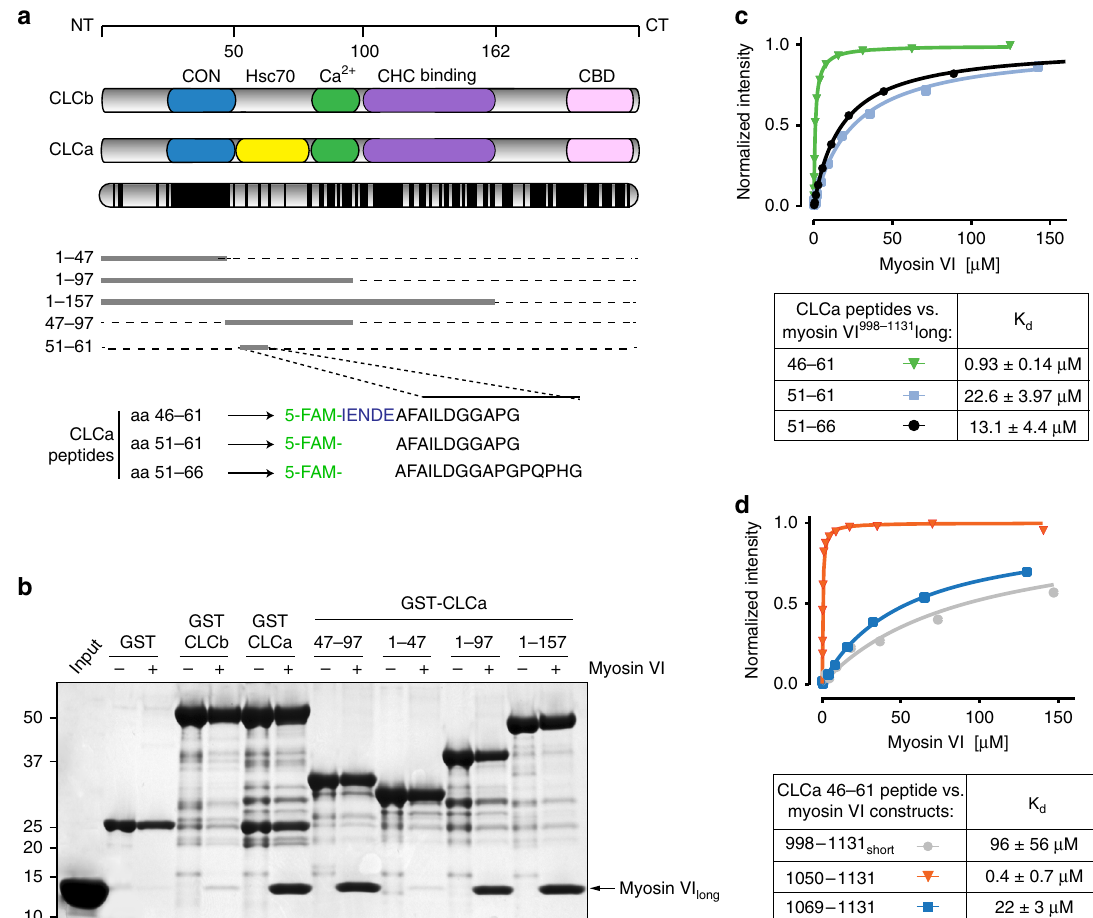
Fig. 2 CLCa:myosin VI long interact with sub-micromolar af fi nity. a Domain structures of CLCa and CLCb. CON conserved Hip-binding region, Hsc70 unique region in CLCa that stimulates Hsc70 activity in vitro, Ca 2 + EF-hand domain that binds calcium, CHC binding clathrin heavy chain binding region, CBD calmodulin-binding domain. Sequence conservation between the two proteins is reported below. Each line represents one amino acid, black line indicates identity. Lower panel, scheme of the selected constructs used in ( b ) together with the sequence of the three overlapping 5-carboxy fl uorescein (5-FAM)- conjugated CLCa peptides used for FP analysis in ( c ). b Pull-down assay with GST-CLCa and CLCb full length and the indicated fragments of CLCa immobilized on glutathione sepharose beads and incubated with the puri fi ed fragment spanning amino acids 998 – 1131 of myosin VI long . After washes, bound proteins were eluted in Laemmli-buffer, resolved through SDS-PAGE, and stained with Coomassie. c FP assay using the three peptides shown in ( a ) and the puri fi ed fragment spanning amino acids 998 – 1131 of myosin VI long . Dissociation constants with their respective 95% con fi dence interval (CI) are reported in the table at the bottom. Graph is representative of three independent experiments used to calculate K d and CI. d FP assay using peptide 46 – 61 of CLCa and the indicated fragments of long and short myosin VI isoforms. Graph, K d , and CI as for ( c